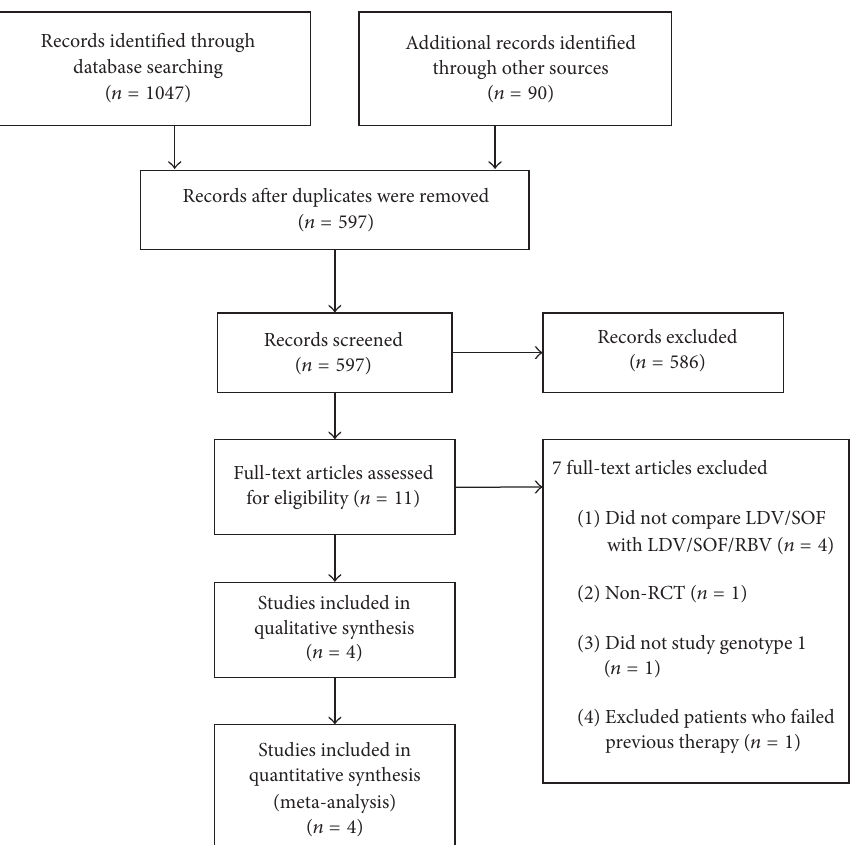
Figure 1: Search strategy results using PRISMA flow diagram